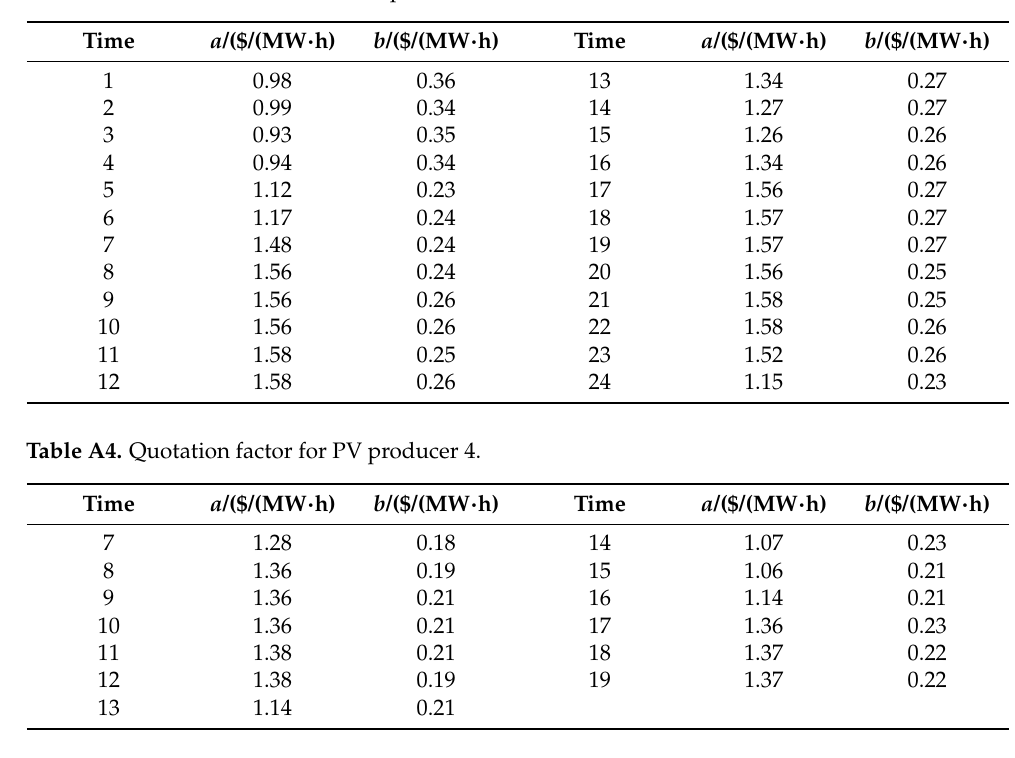
Table A3. Quotation factor for wind producer 3.